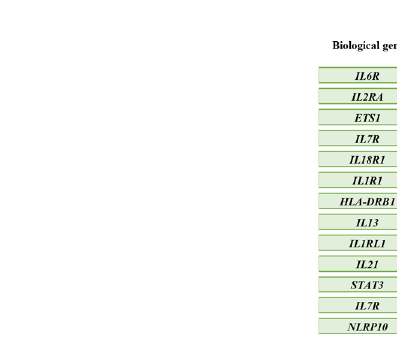
FIGURE 4 | Connections between biological AD risk genes and drugs are potentially useful for AD. Representative connections between AD biological genes (green); genes in PPIs (yellow); target drug for drugs under clinical trial (blue); the drug was supported by case series (pink), and drugs with preclinical data for AD (grey); indication (orange). Grey lines indicate connections. All other biological gene-drug connections are through the PPI network.